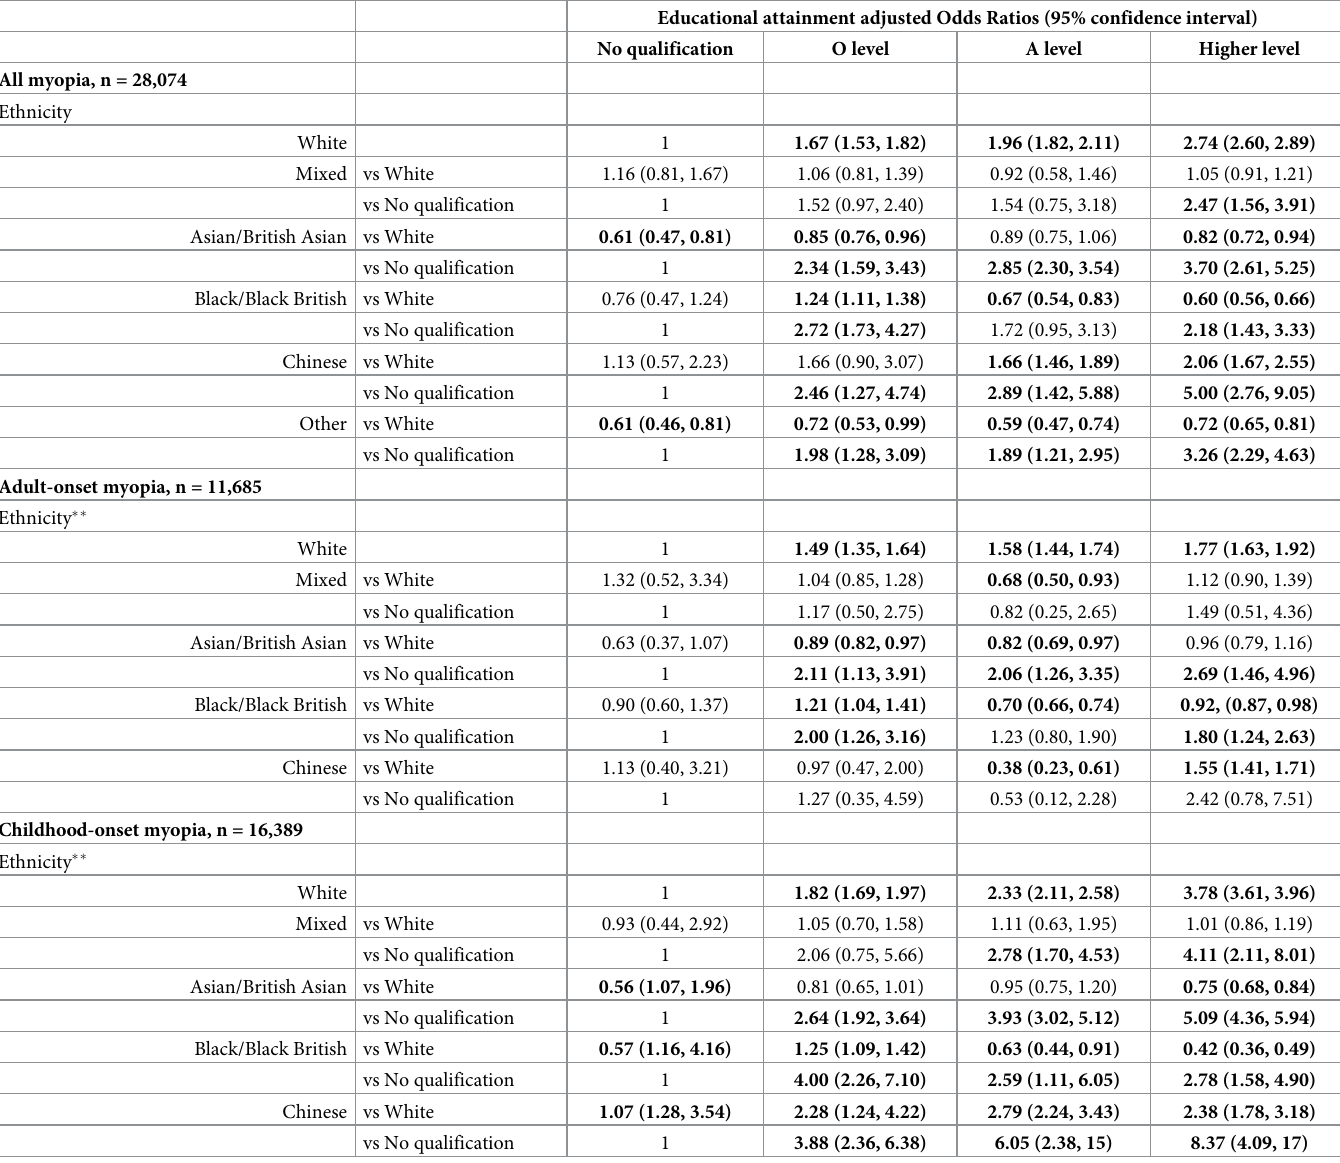
Table 4. Interactions in associations with myopia (all, childhood-onset and adult -onset) between ethnicity and no educational